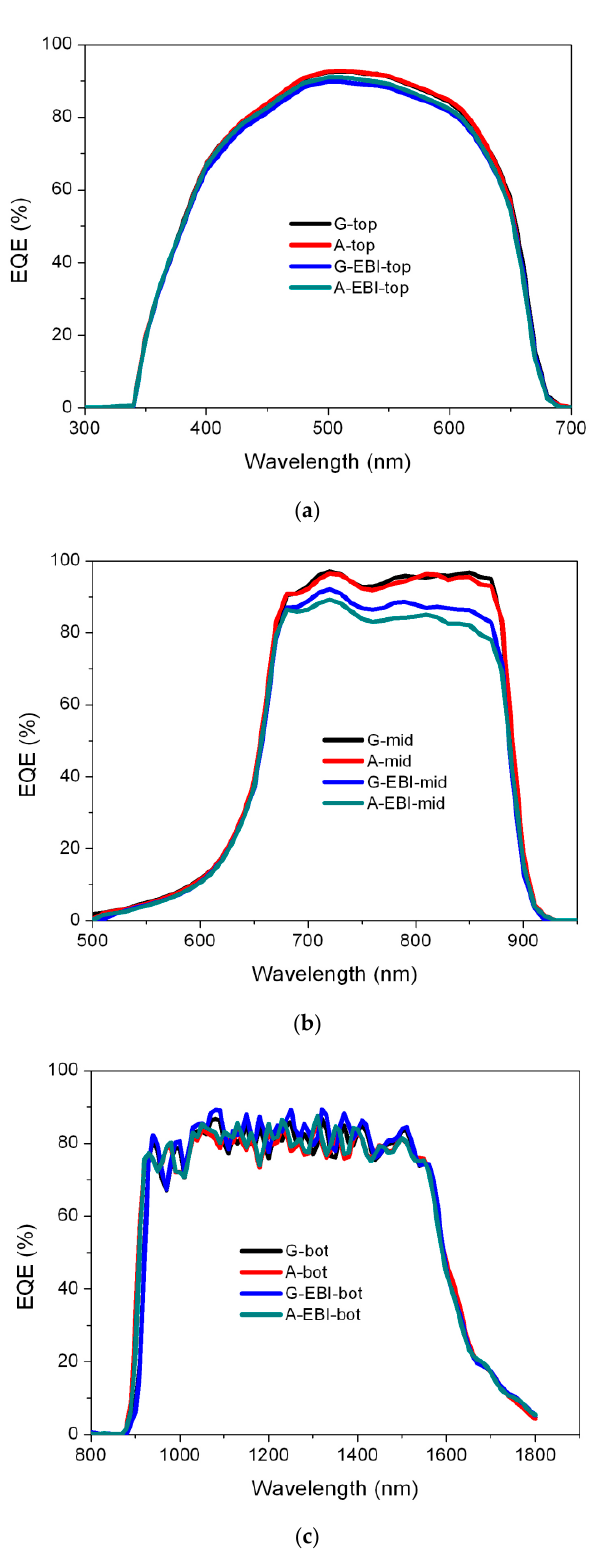
Figure 4. External quantum e ffi ciency (EQE) curves of solar cells before (G, A) and after (G-EBI, A-EBI) electron beam irradiation: ( a ) EQE result of top subcells; ( b ) EQE result of middle subcells; ( c ) EQE result of bottom